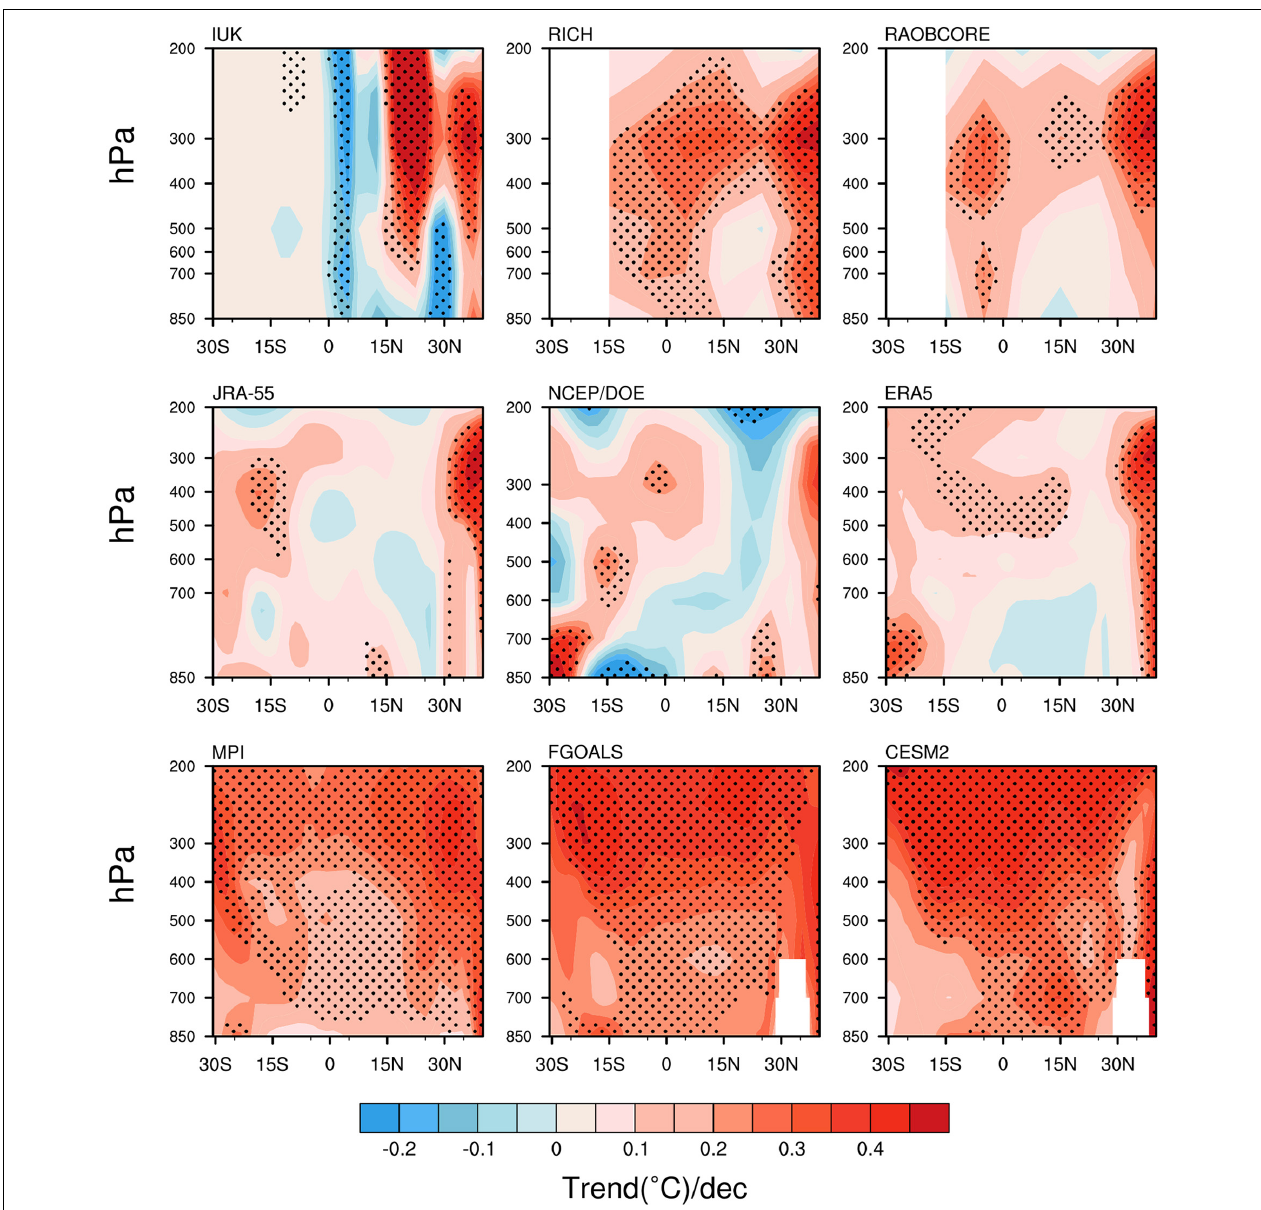
FIGURE 7 | The vertical profile of the summer temperature trend at 80 ◦ E–100 ◦ E ( ◦